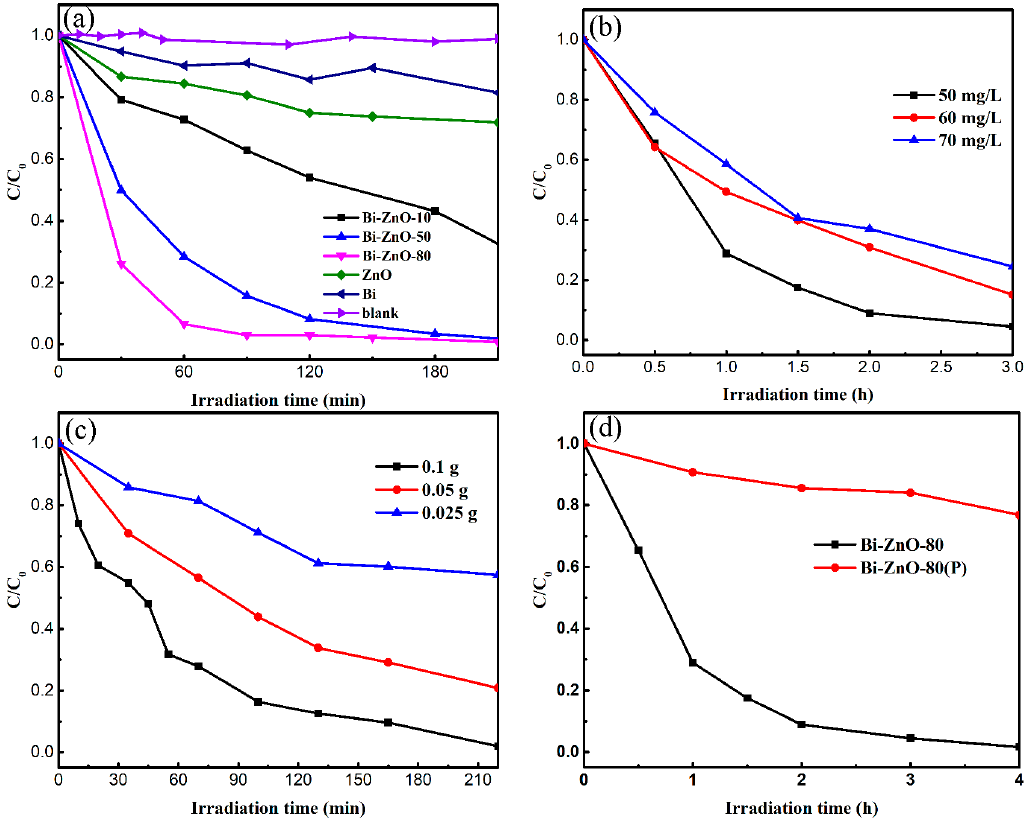
Figure 7. ( a ) Photoreduction of aqueous Cr(VI) using BiNPs/ZnO, Bi and ZnO photocatalysts under visiblelight irradiation, ( b ) Photocatalytic reduction of Cr(VI) of different initial concentration by Bi-ZnO-80 composite, ( c ) Photocatalytic reduction of Cr(VI) by different dosage of Bi-ZnO-80 composite, ( d ) Photoreduction of aqueous Cr(VI) using Bi-ZnO-80 composite synthesized by Bi-ZnO-80 and Bi-ZnO-80(P) under visiblelight irradiation.